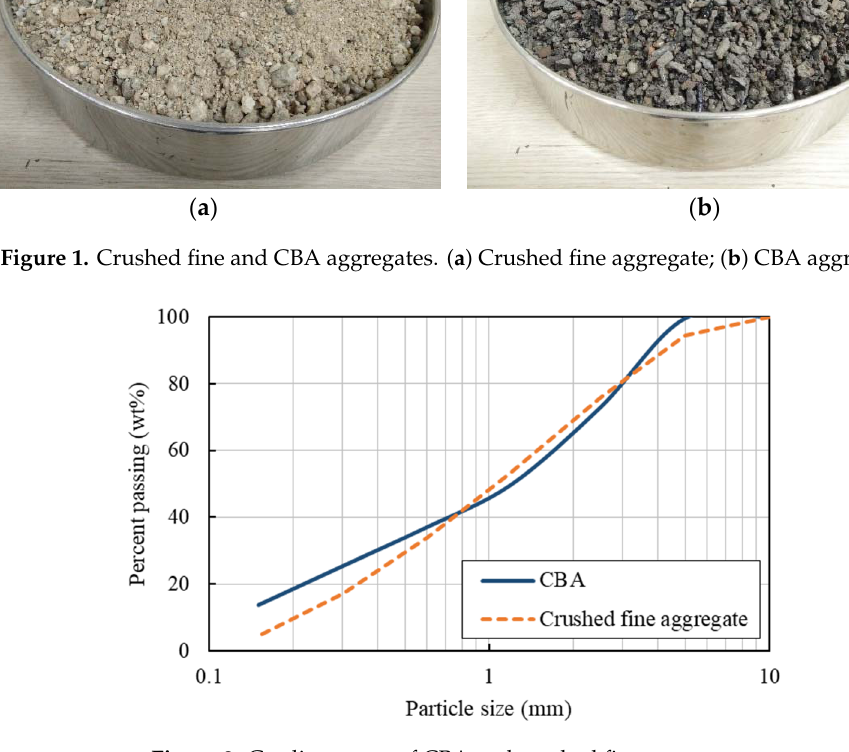
Figure 2. Grading curve of CBA and crushed fine aggregates. Table 1. Physical properties of fine, coarse and coal bottom ash (CBA)